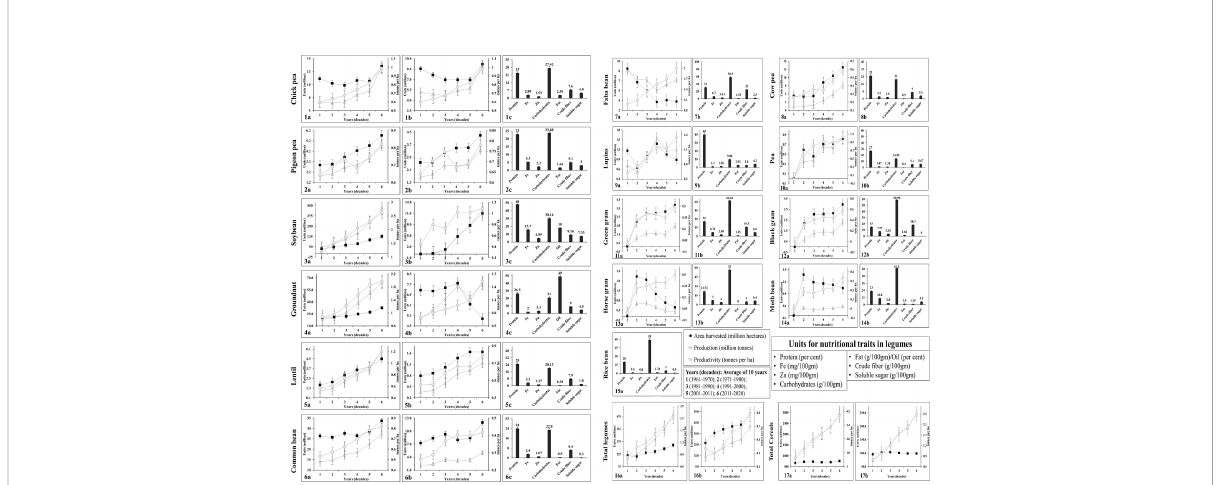
FIGURE 1 Area (in million hectare), production (in million tonnes), and productivity (in tonnes per hectare) from 1961 to 2020 (World and India) and nutritional quality traits (protein, Fe, Zn, carbohydrates, fat/oil, crude fi ber, and soluble sugar) of legume crops. Area, production, productivity trend of World and India and nutritional quality traits (right) of chickpea (1a-c); pigeon pea (2a-c); soybean (3a-c), groundnut (4a-c), lentil (5a-c), and common bean (6a-c). World ’ s area, production, productivity and nutritional quality traits offaba bean (7a-b), cowpea (8a-b), and lupins (9a-b); India ’ s area, production, productivity and nutritional quality traits of pea (10a-b), green gram (11a-b), black gram (12a-b), horse gram (13a-b), and moth bean (14a-b); nutritional quality traits of rice bean (15a); Area, production, and productivity of total legume crops in world (16a) and India (16b); Area, production, and productivity of total cereals (including millets) in world (17a) and India (17b). Information for the worlds and India ’ s area, production and productivity (from 1961 to 2020) of all crops were collected from FAOSTAT (https://www.fao.org) and Indiastat (https://www.indiastat.com) respectively. Information for the nutritional quality traits were collected from the published articles of respective